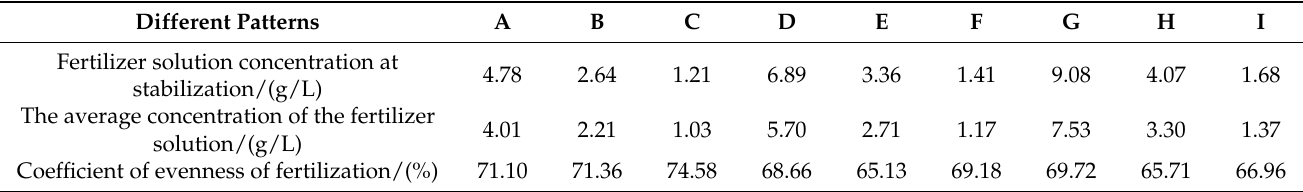
Table 3. Fertilizer performance parameters of the solution application device under different fertilizer flow rates and water flow rates.